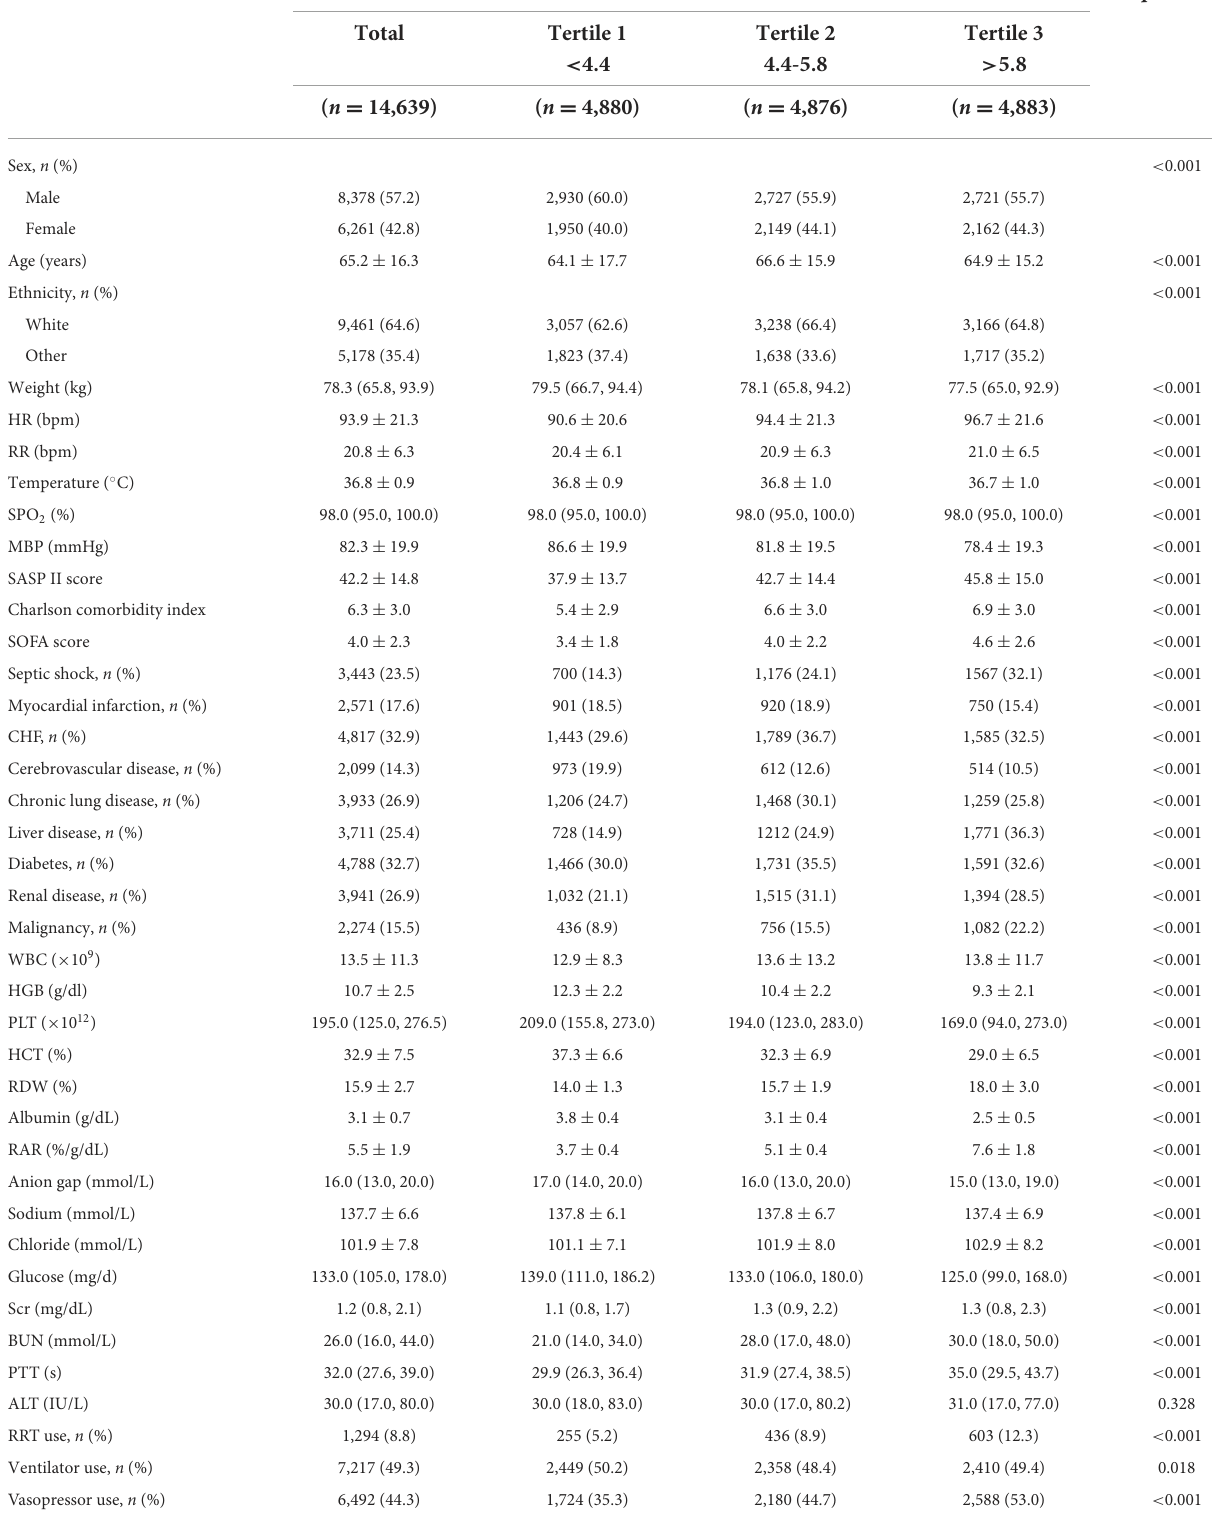
TABLE 1 Baselineclinical and laboratory characteristics of the study patients.